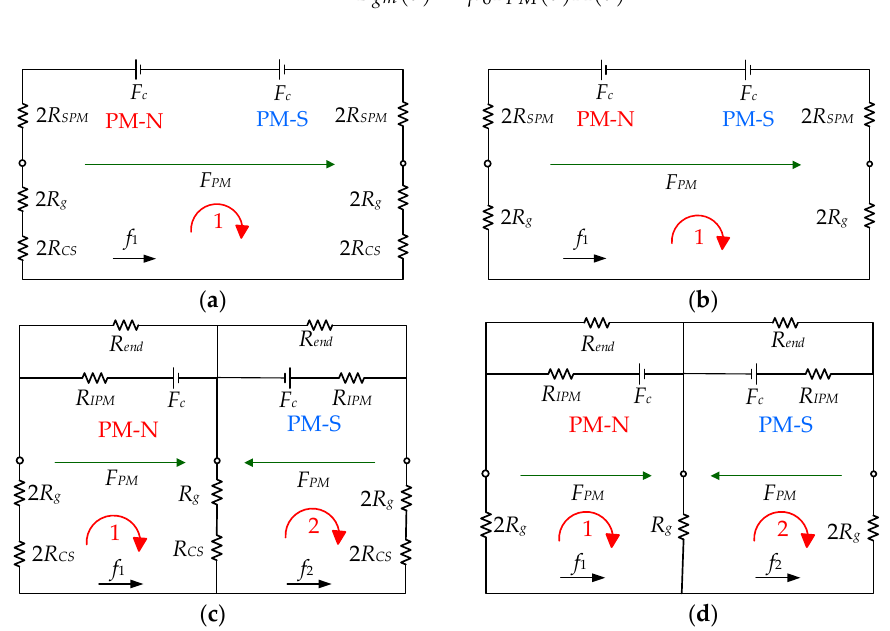
Figure 2. The equivalent magnetic circuit (EMC) models of the four typical PMECCs: ( a ) Model − A; ( b ) Model − B; ( c ) Model − C; ( d ) Model − D.